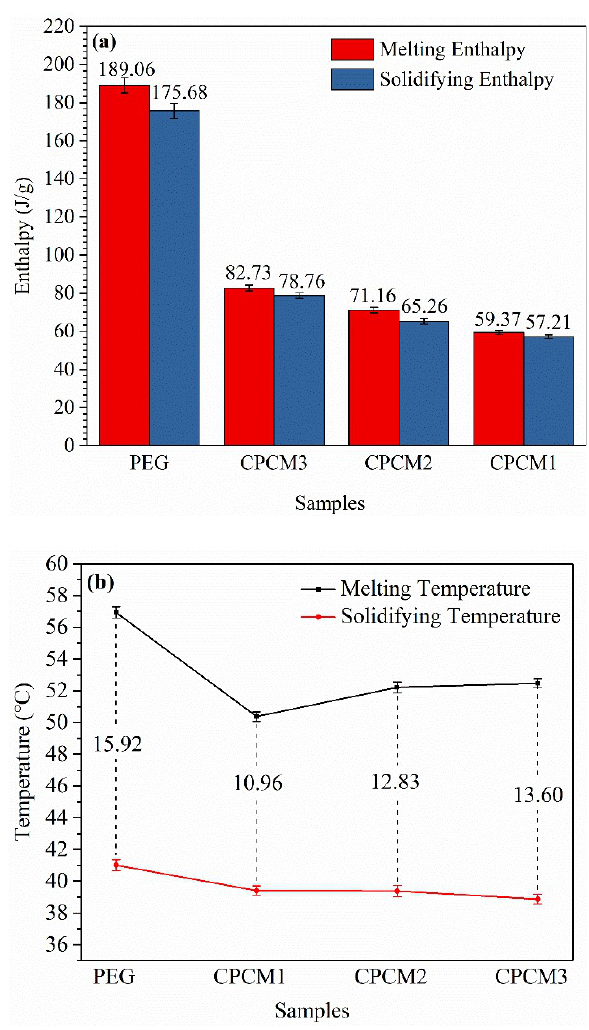
Figure 9. Enthalpies of melting and solidification ( a ); Supercooling of PEG and CPCMs ( b ).